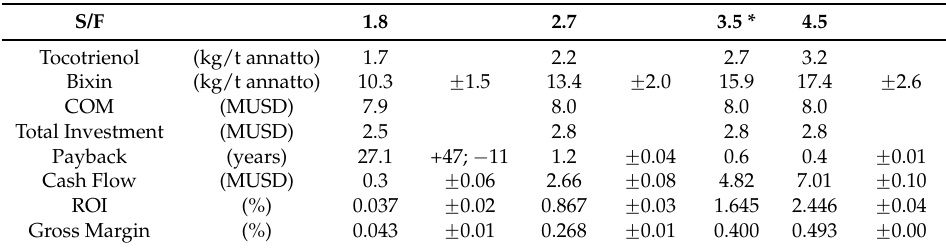
Table 6. Sensitivity analysis of SFE S/F for configuration